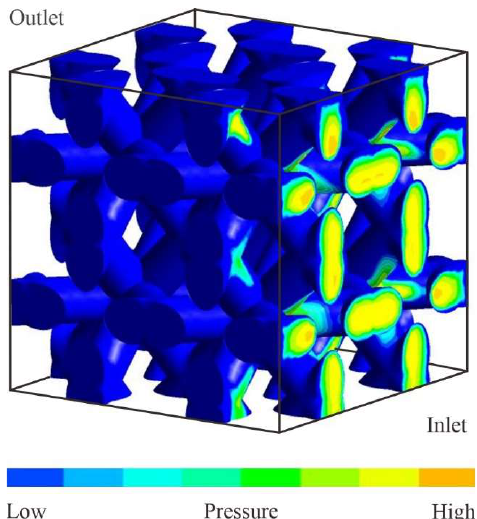
Figure 8. The surface temperature distribution on the yttria-stabilized zirconia (YSZ) lattices simu- lated by the finite element method (FEM). Displayed red and orange contours indicate high and low-temperature distributions transferred for the molten salt flowing and filling the sterically prop- agated 12-coordinated lattices.